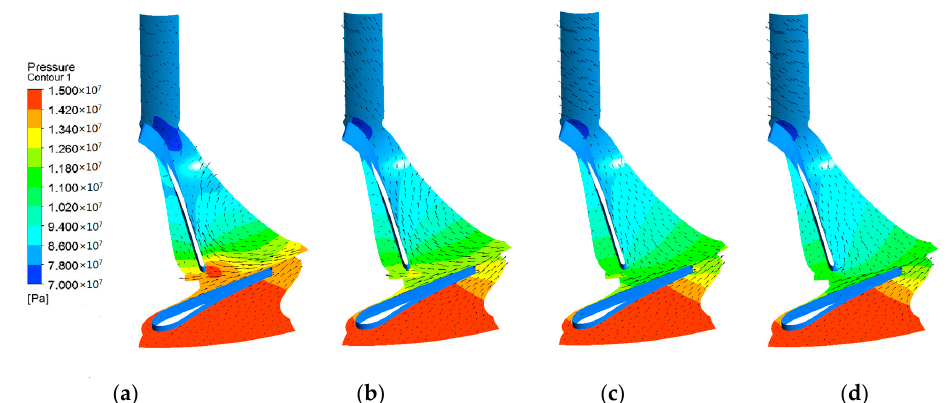
Figure 7. Pressure contours with vectors at the mid-span when LED = 4 mm: ( a ) T in = 400 K; ( b ) T in = 450 K; ( c ) T in = 550 K; ( d ) T in = 650 K.